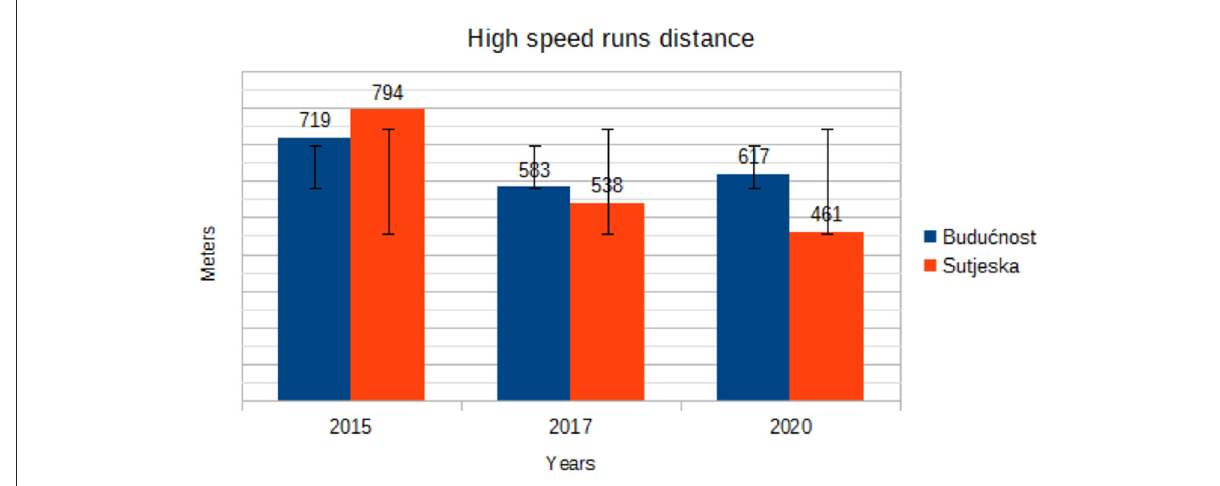
FIGURE5 Trend in mean high speed runs distance by years.